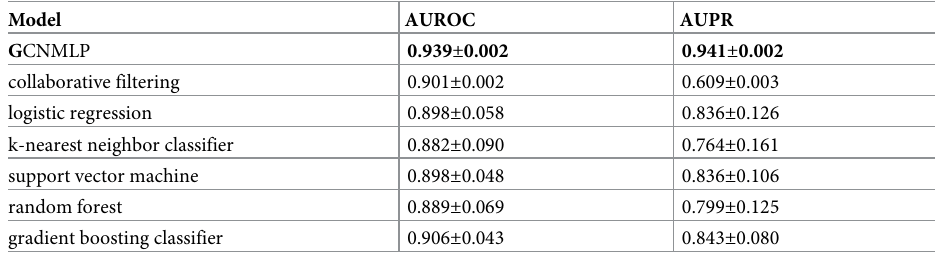
Table 7. Comparing the performance of the GCNMLP with various machine learning methods for SIDER.